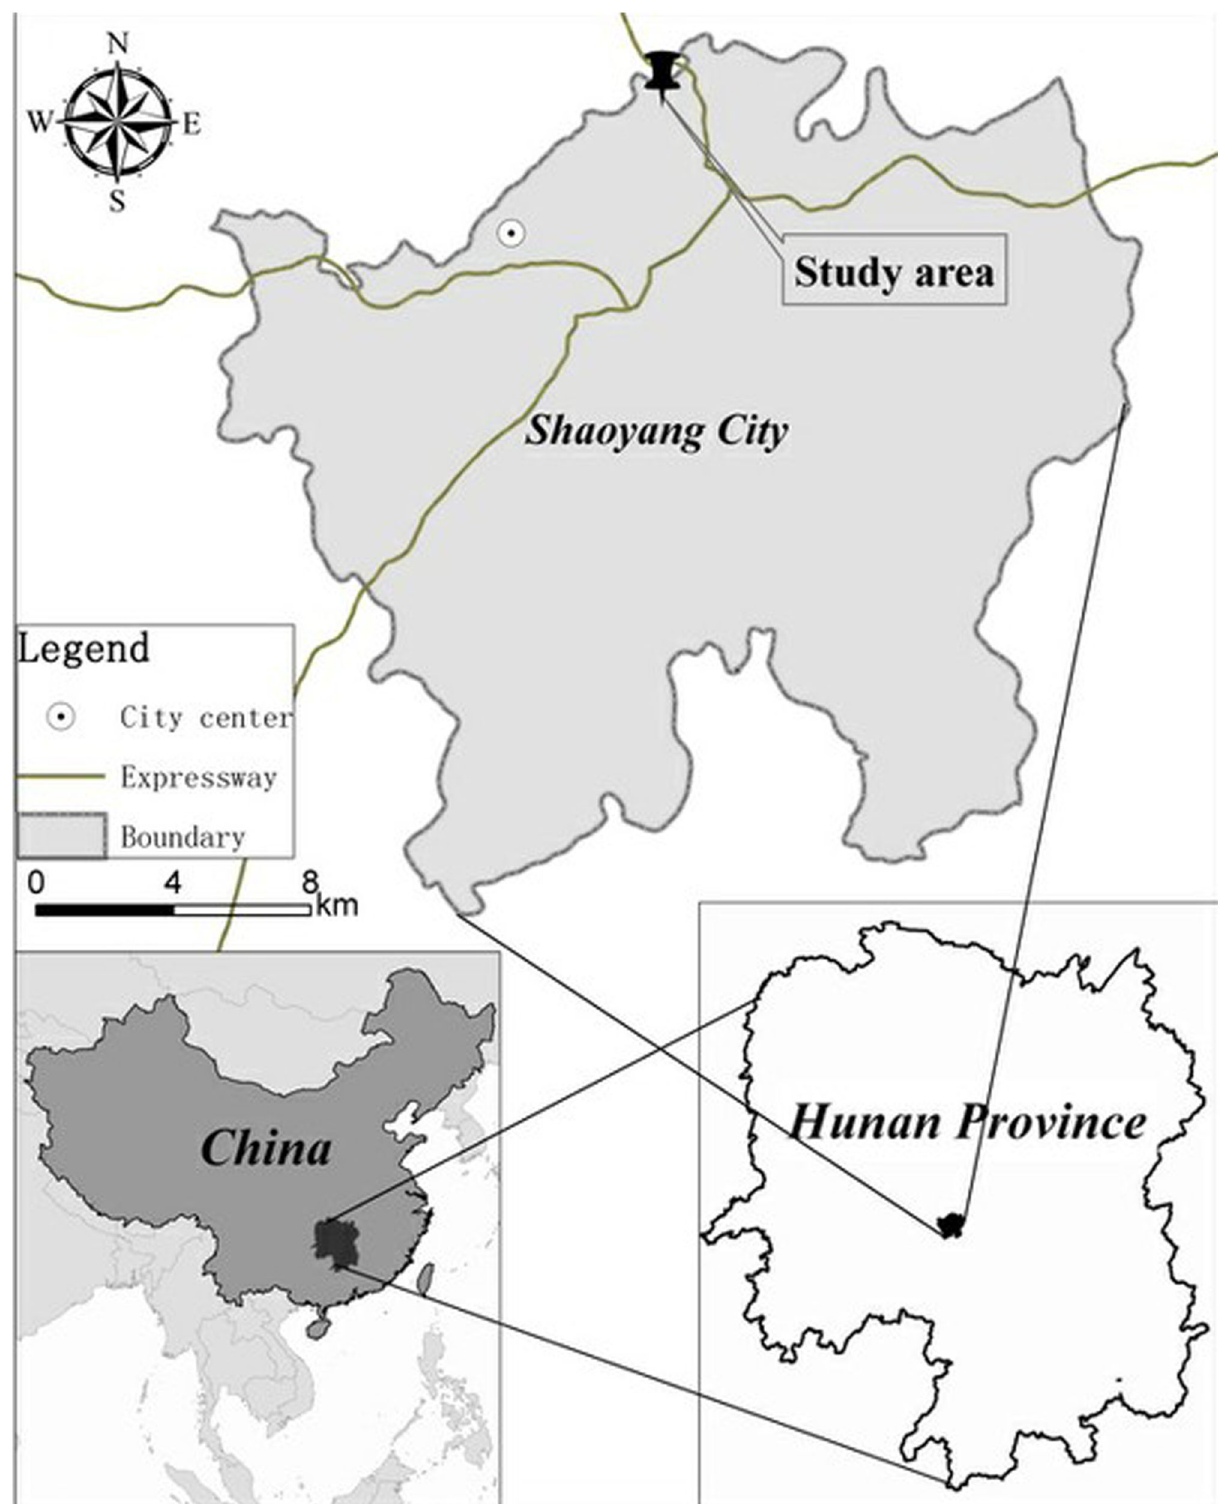
Figure 1. Location of the study area.